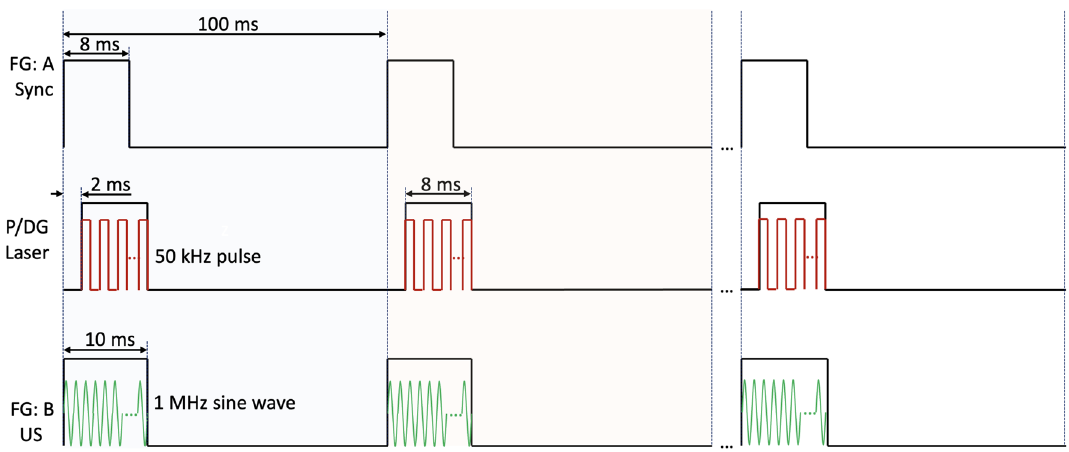
Figure 5. Timing diagram. FG function generator, P/DG pulse delay generator, US